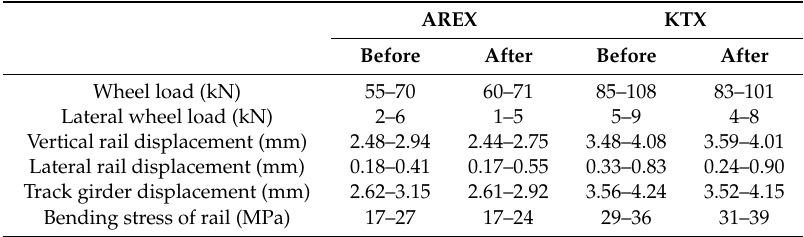
Table 2. Ranges of the rail before and after rail pad replacements.